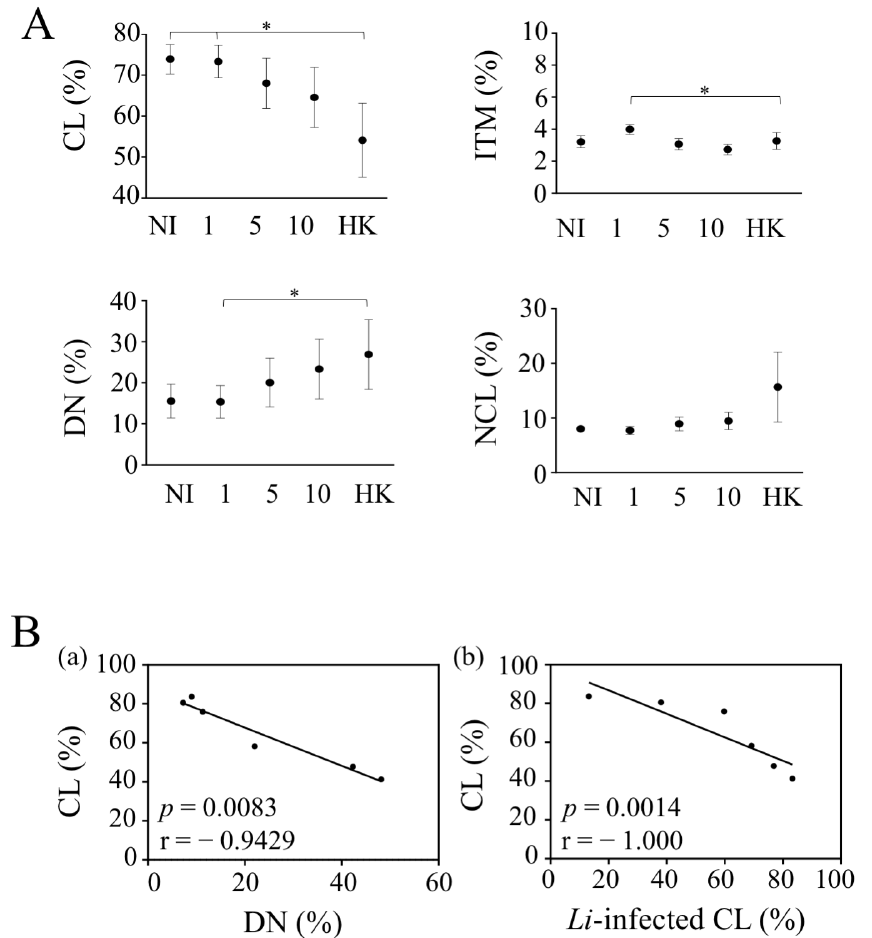
Figure 4. Leishmania infantum impacts monocyte cell subsets. ( A ) The percentages of each monocyte cell subsets were analyzed after 4 h of culture or exposition to different doses of live and heat-killed parasites (1.10 6 , 5.10 6 and 10.10 6 /mL and HK-10.10 6 /mL). Statistical analyses were performed using a Two-Way ANOVA test with a Tukey analysis (* p < 0.05; n = 6). ( B ) ( a ) Correlation between the percentages of CL and DN. ( b ) Correlation between the percentage of CL-infected cells and the percentage of CL, 4 h after infection. Each dot represents one individual. Correlation was assessed using Spearman test, and r and p are shown in the figure.